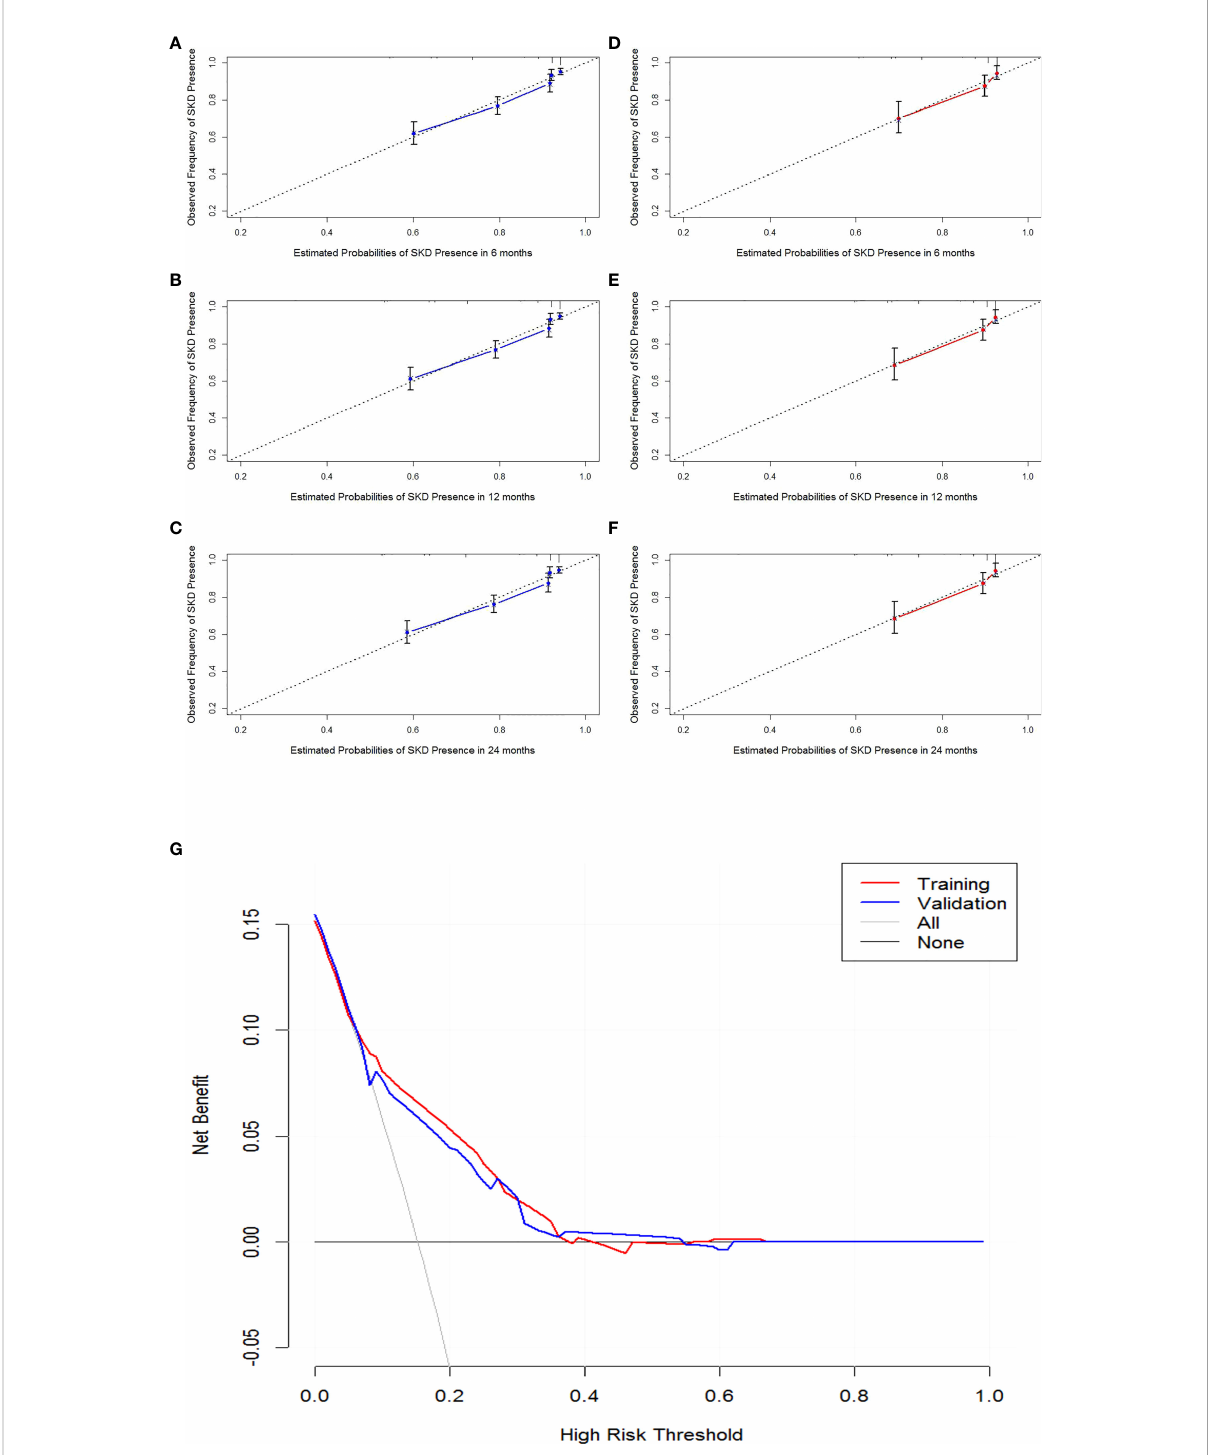
FIGURE 3 Calibration curves of 6-month, 1-year, and 2-year SKD and the decision curve analysis (DCA) for the nomogram. Calibration curve of the nomogram in the training cohort (A – C) . Calibration curve of the nomogram in the validation cohort (D – F) . The DCA for the nomogram in training and validation dataset (G) . The gray line represents the assumption that all patients have SKD. Thin black line (parallel to the x-axis) indicates that no patients have SKD. The blue line represents prediction nomogram scheme in validation dataset. The red line represents prediction nomogram scheme in training dataset. SKD, severe kidney